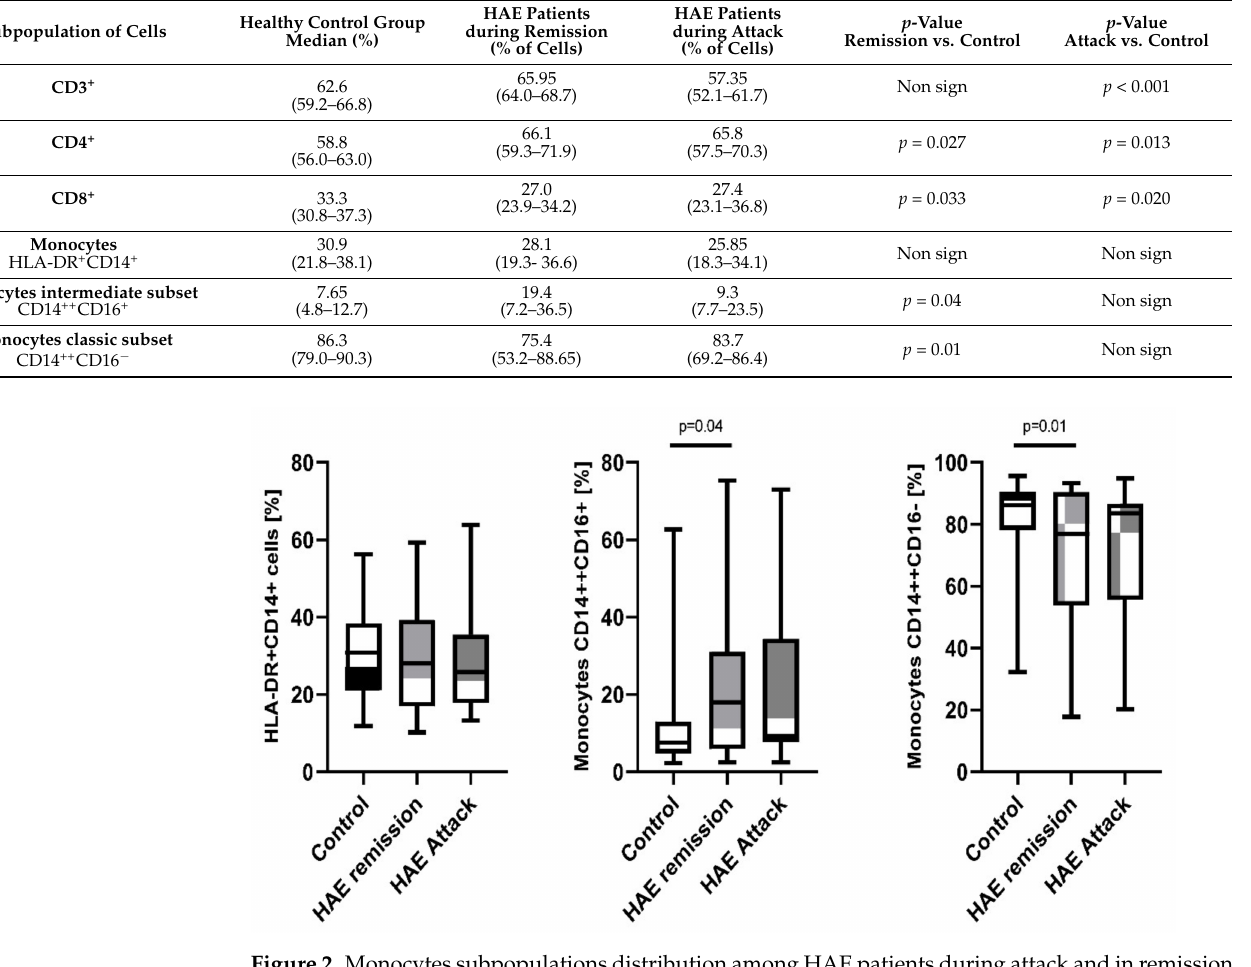
Figure 2. Monocytes subpopulations distribution among HAE patients during attack and in remission compared to the healthy control